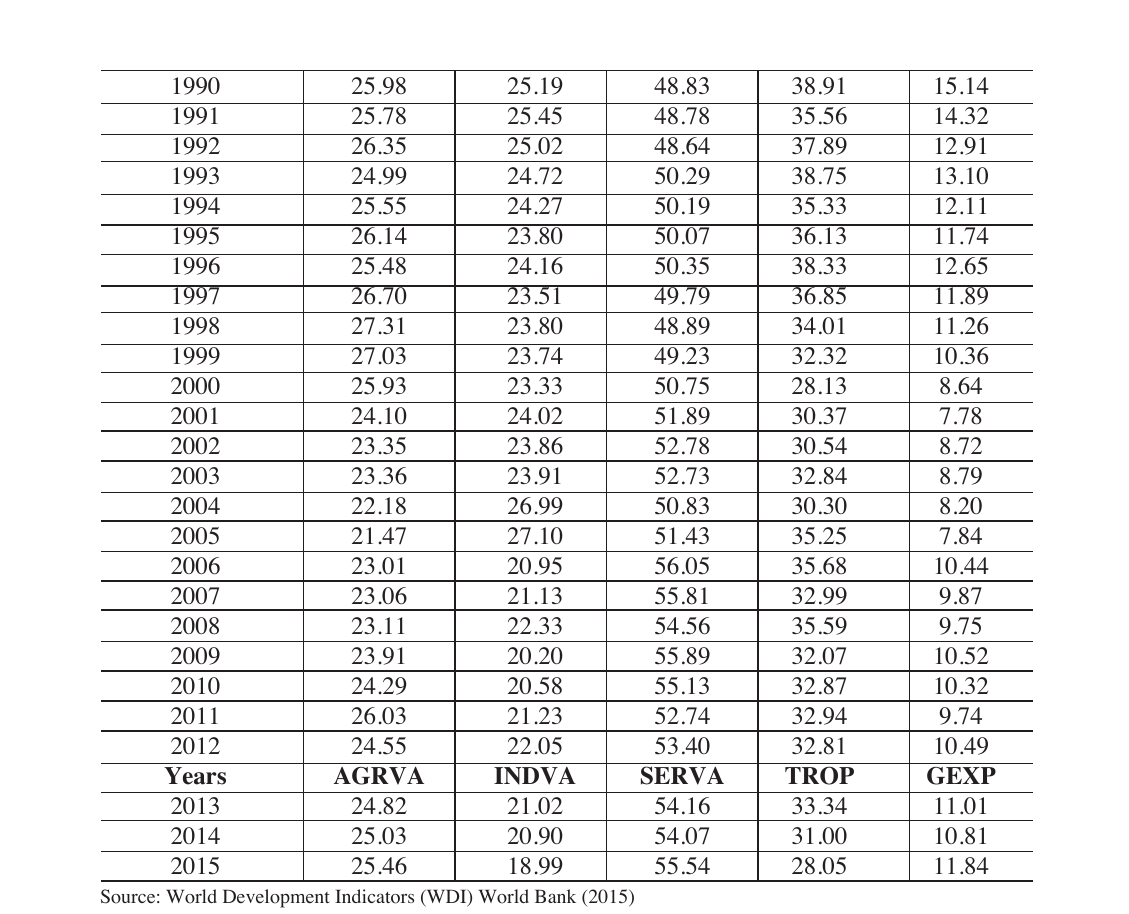
Table A6: Data for Alternative